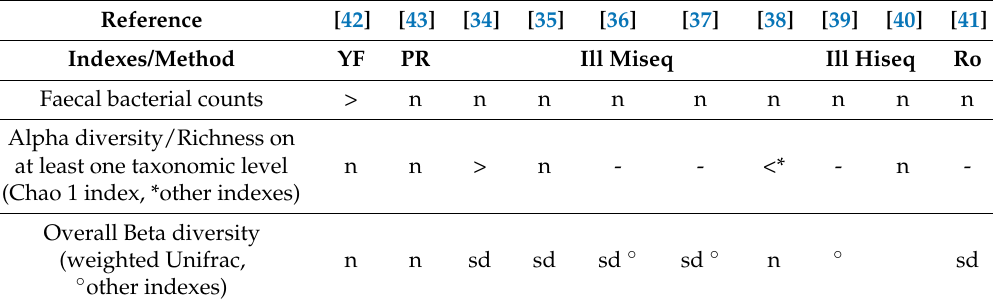
Table 2. Richness, alpha diversity, beta